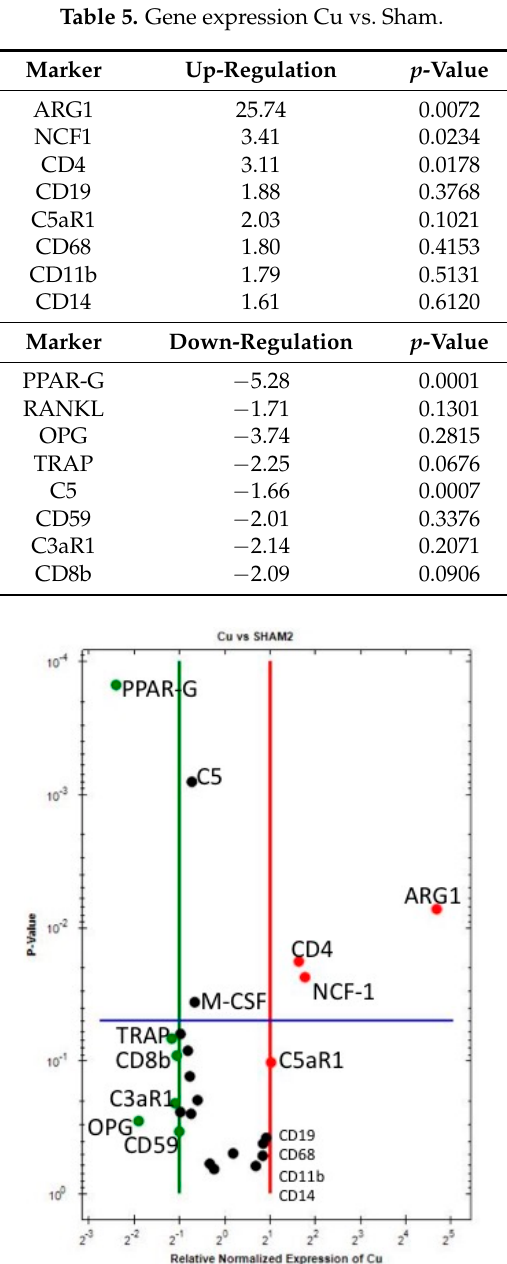
Figure 3. Volcano plot comparing the gene expression of Cu versus Sh at 10 days. Downregulation (vertical green line) and Upregulation (vertical red line) set a × 2 regulation. Statistical significance (horizontal blue line) set at p < 0.05—Marker is significant when above blue line. Table 5. Gene expression Cu vs. Sham.